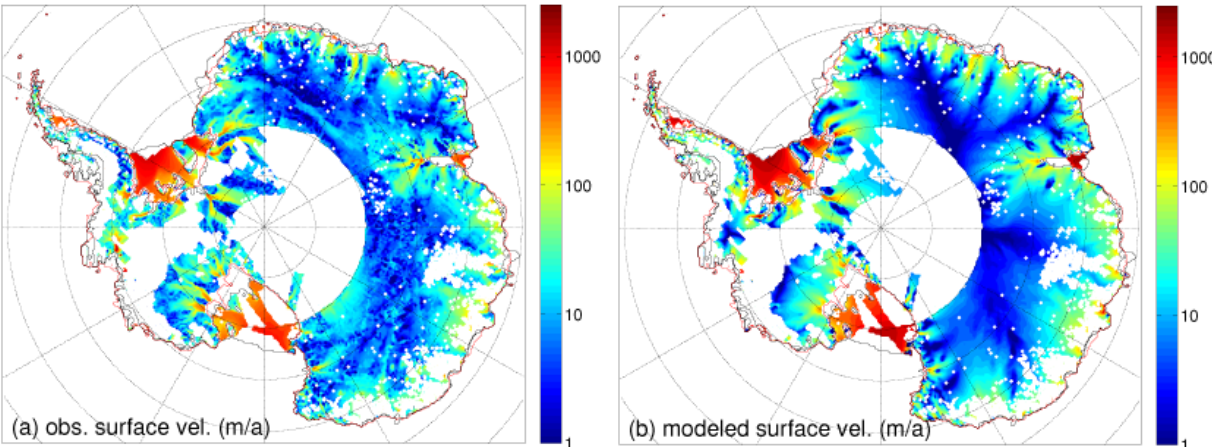
Fig. 13. Comparison of surface velocity fields. (a) Observed surface velocities from MAMM data enriched by data from Joughin et al. (2002). (b) Surface velocities from equilibrium simulation. In both (a) and (b) , regions without observational coverage and where there is no agreement in the simulation and the observations about whether the ice is grounded or floating are masked out, which leaves 65% of total ice covered area for comparison. The respective grounding line positions and calving fronts for observation and model are depicted in black and red, as in Fig.